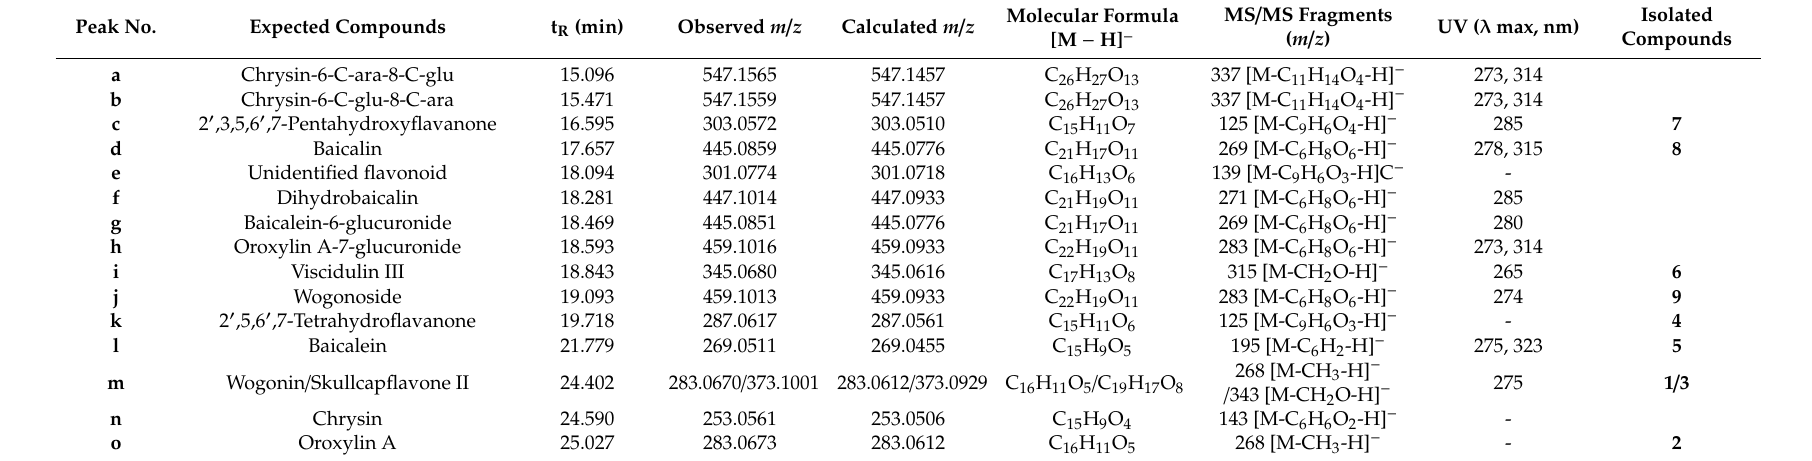
Table 1. LC-MS analysis of constituents in the MeOH extract of S. baicalensis in Figure 1. Peak